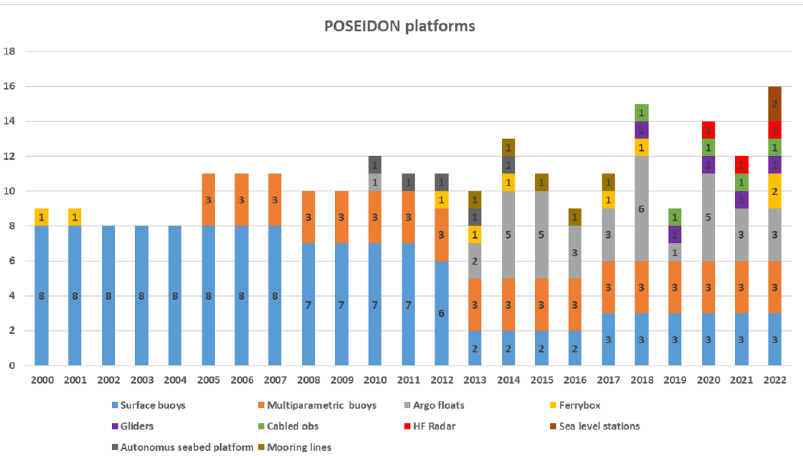
Figure 1. The evolution of the POSEIDON system with the addition of new platforms and technol- ogies for 2000 – 2022. gies for